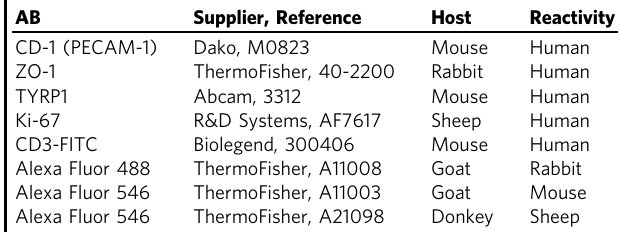
Table 2 Immuno fl uorescence